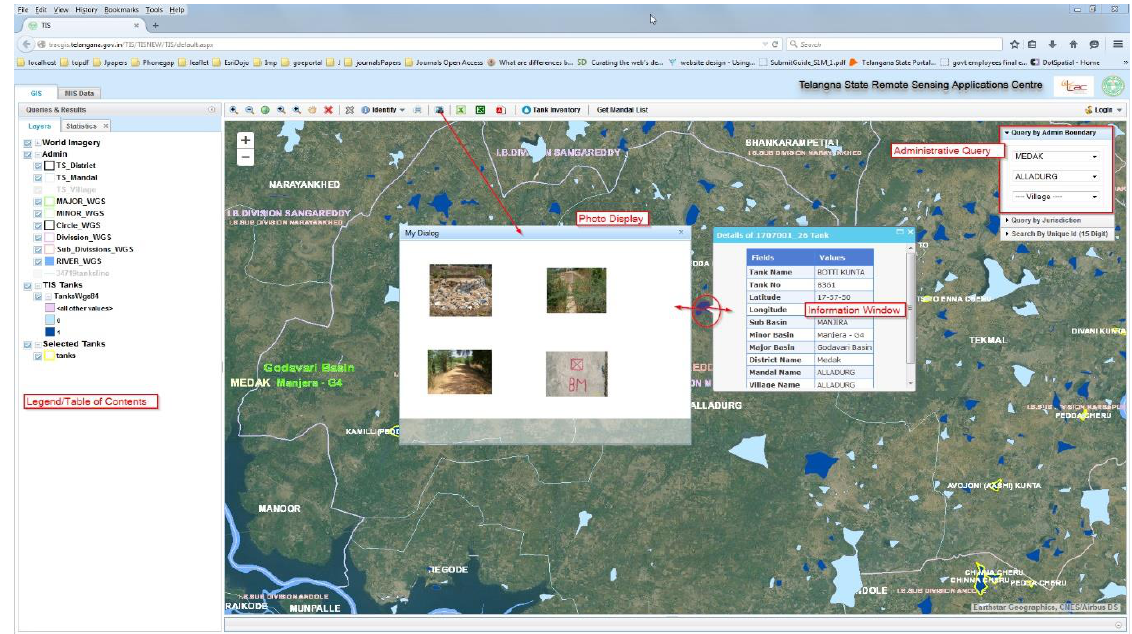
Figure 3 : TIS Application developed using ArcGIS API for JavaScript and Dojo Toolkit